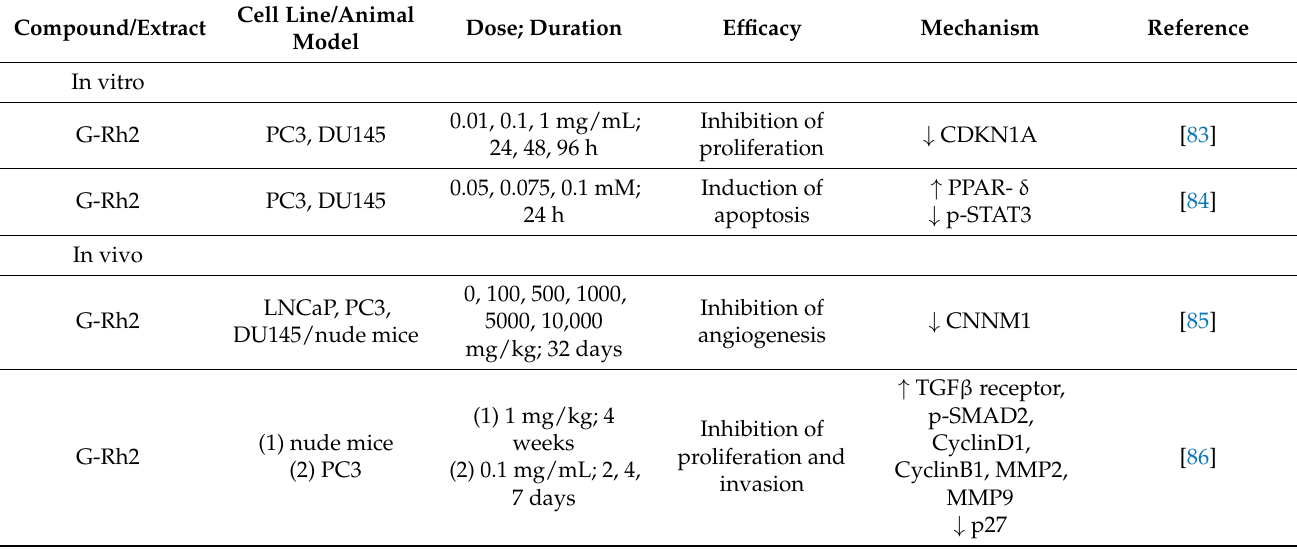
Table 4. Panax ginseng and its metabolites against prostate